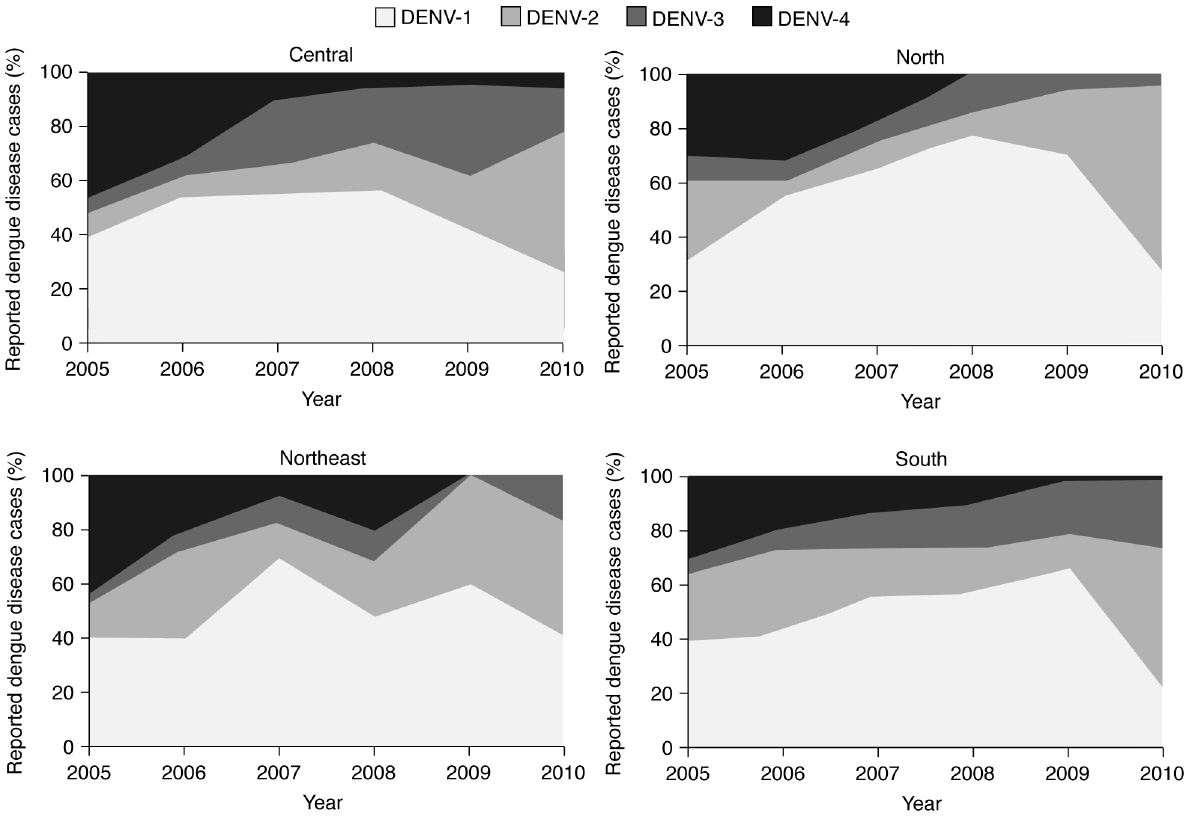
Figure 7. Change in pattern of circulating dengue virus serotypes by year and region, Thailand, 2005–2010 [28–33]. Regional DENV serotype data for the period 2005–2010 show similar patterns in each region. Broadly, there was a reduction in the proportion of DENV-1 and an increase in the proportion of DENV-2 in all regions. The proportion of DENV-3 was variable by time and between regions, whereas DENV-4 only remained in circulation throughout this 5-year period in the Central region. DENV, dengue virus. *Data for 2000–2004 not available from source material.